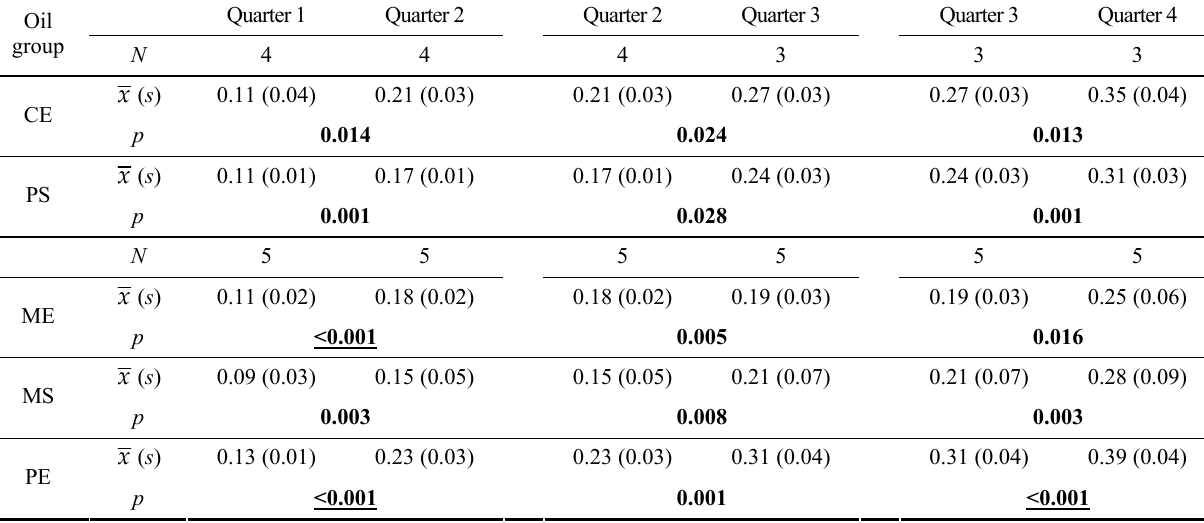
Table 3 The mean values, standard deviations, and * p values for oxidation.